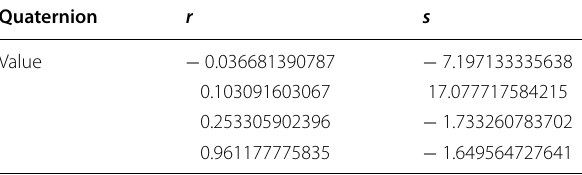
Table 8 Calculated transformation parameters by ADQA, MPA, and